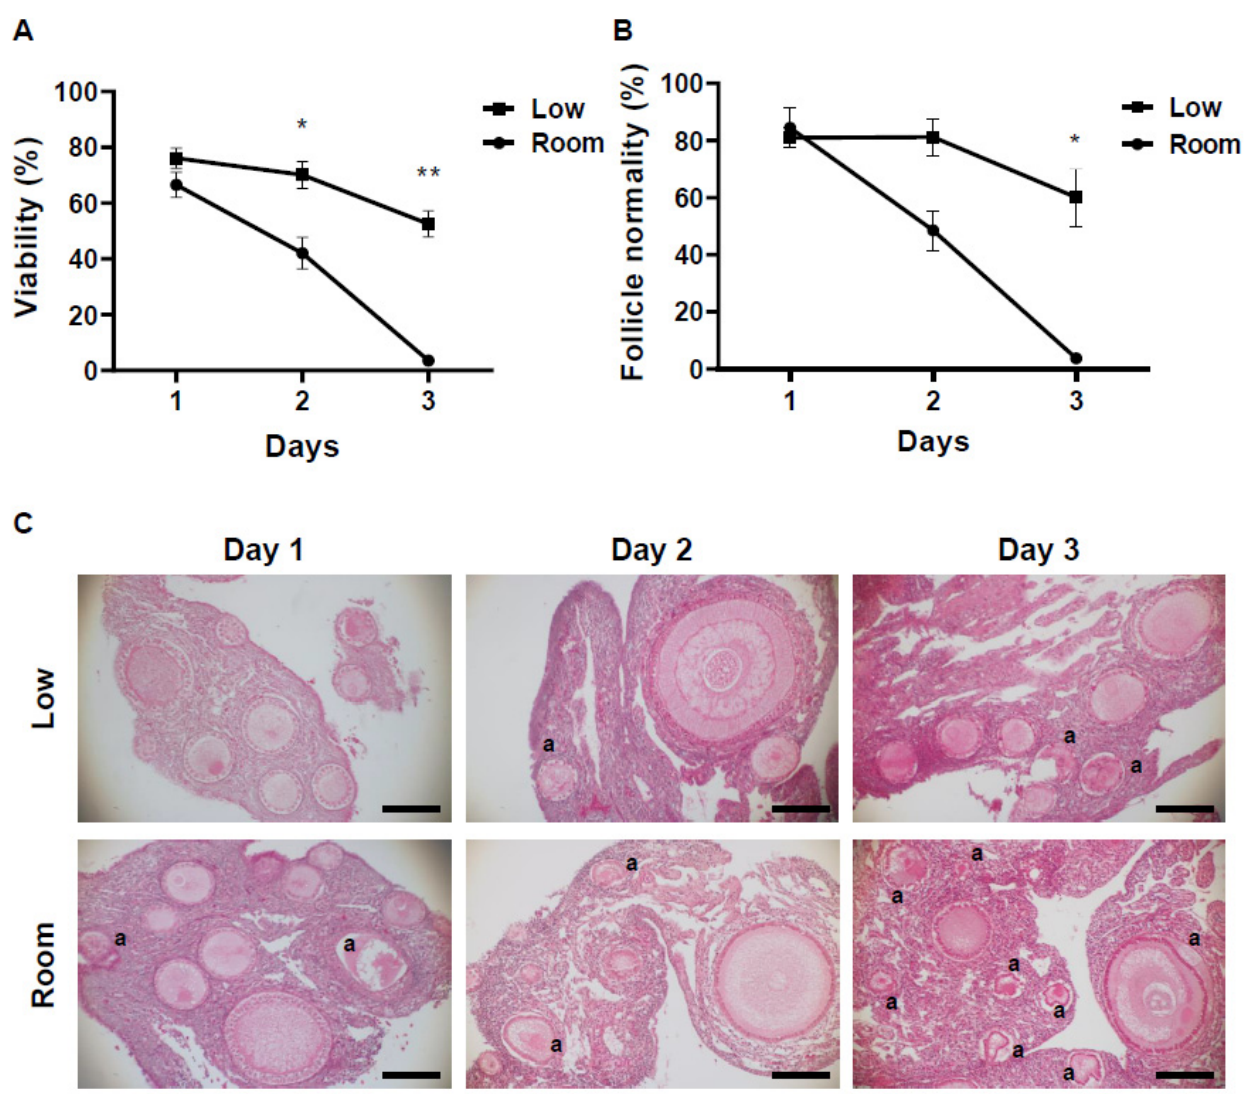
Figure 2. Influence of different storage conditions on follicle viability within ovarian tissues evaluated by neutral red (NR) and histological analysis. ( A ) Mean ( ± SEM) percentages of follicle viability in different conditions (low temperature, room temperature for 1 to 3 days). * indicate statistically significant differences (* p < 0.005, ** p < 0.0001) in the percentages of survived follicles. ( B ) Mean (± SEM) percentages of morphologically normal follicle in hen ovary stored in different conditions (low temperature, room temperature for 1 to 3 days). * indicate statistically significant differences ( p < 0.05) in the percentages of morphologically normal follicles. ( C ) Histomicrographs of ovarian tissue stored in different conditions (low temperature, room temperature for 1 to 3 days). “a” indicates the abnormal follicles. Bar = 100 μ m.